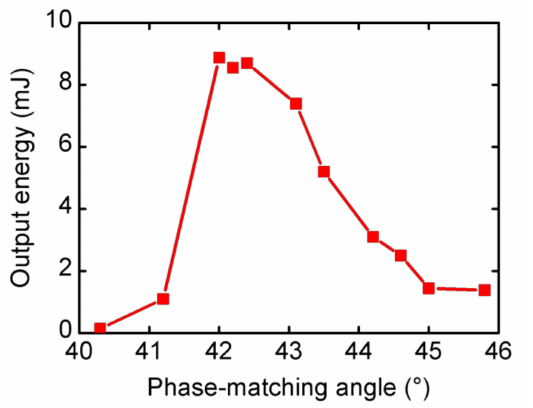
Figure 5. The energy of the visible lasers with di ff erent angles of the KDP